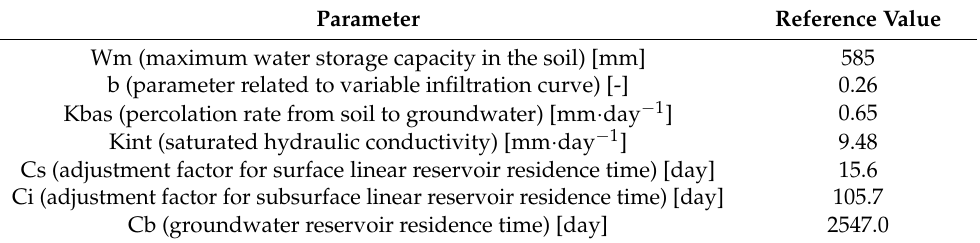
Table 2. Reference values for the a priori distribution (initial guess) of MGB parameters for each HRU (except for CS, CI, and CB parameters, which were constant for the whole basin), derived from the average values of the MGB model application for South America [45]. Each initial set of parameters (total of 500 sets for each of the three calibration scenarios) was obtained by estimating the parameter values with a uniform distribution within a range of 10% to 400% of the reference value defined by this table.